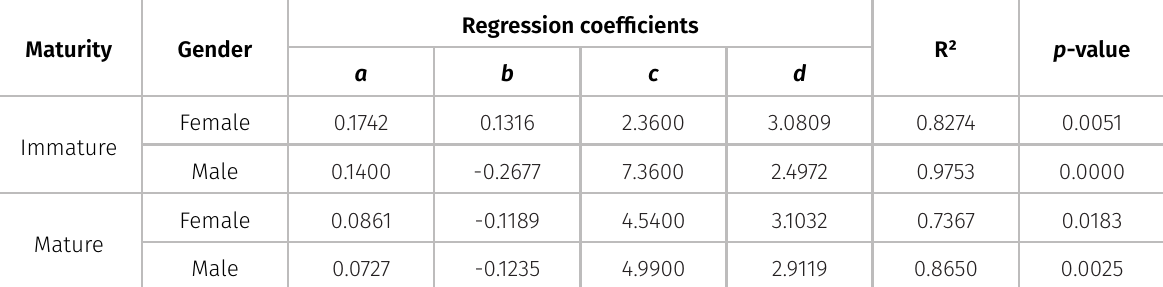
Figure 2. Allometric coefficients of males (triangles) and females (circles) of Xiphopenaeus kroyeri from northern Rio de Janeiro State, SE Brazil, during the sampling years (2005 to 2013). Close and open symbols represent mature and immature stages, respectively. The allometric coefficients for each combination of year, gender and maturity are in Table SI. Sine-cosine models’ statistics (equations, determination coefficients (R²) and p -values are in Table II.